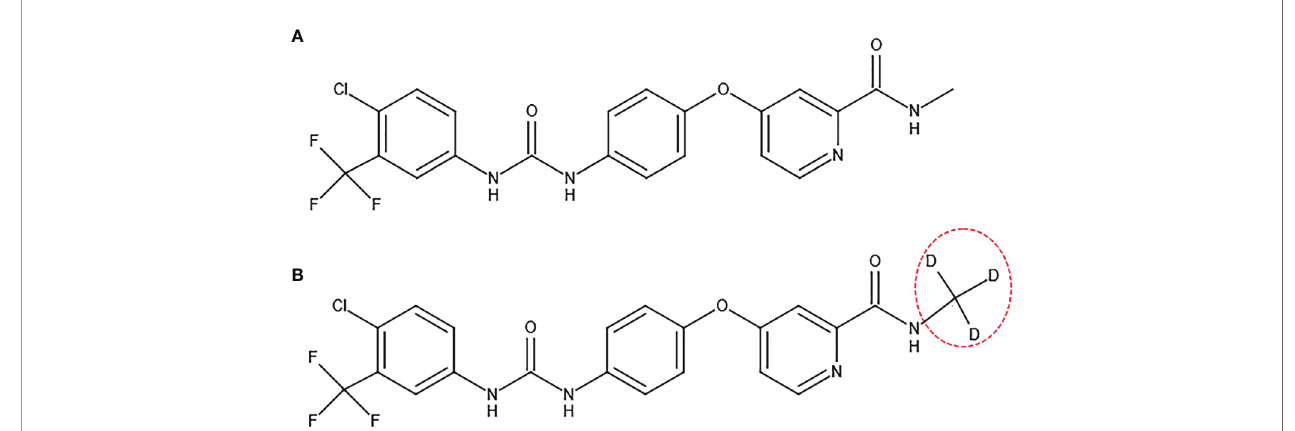
FIGURE 3 | Molecular structures of sorafenib (A) and donafenib (B)